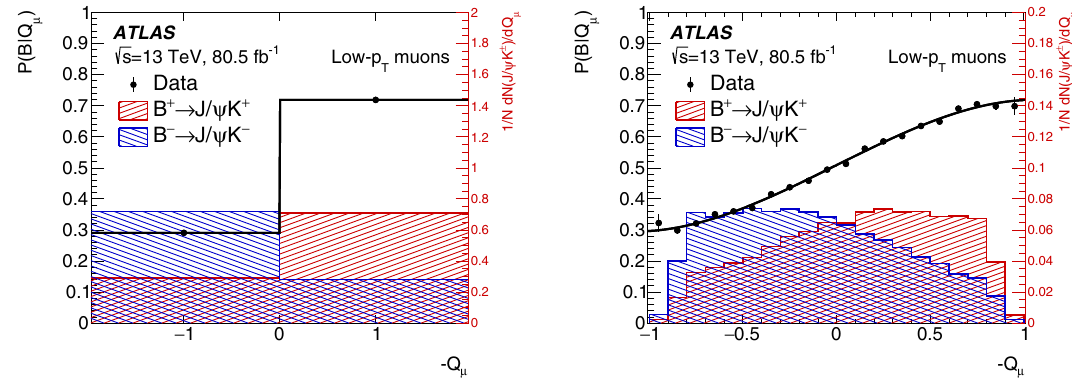
Fig. 3 Normalised cone charge distributions (shown against the right axis scale), − Q μ , for B + ( B − ) events shown in red (blue) for Low- p T muons, for cases of discrete charge (left), and for the continuous distribution (right). Superimposed is the distribution of the tagging probability, P ( B | Q μ )